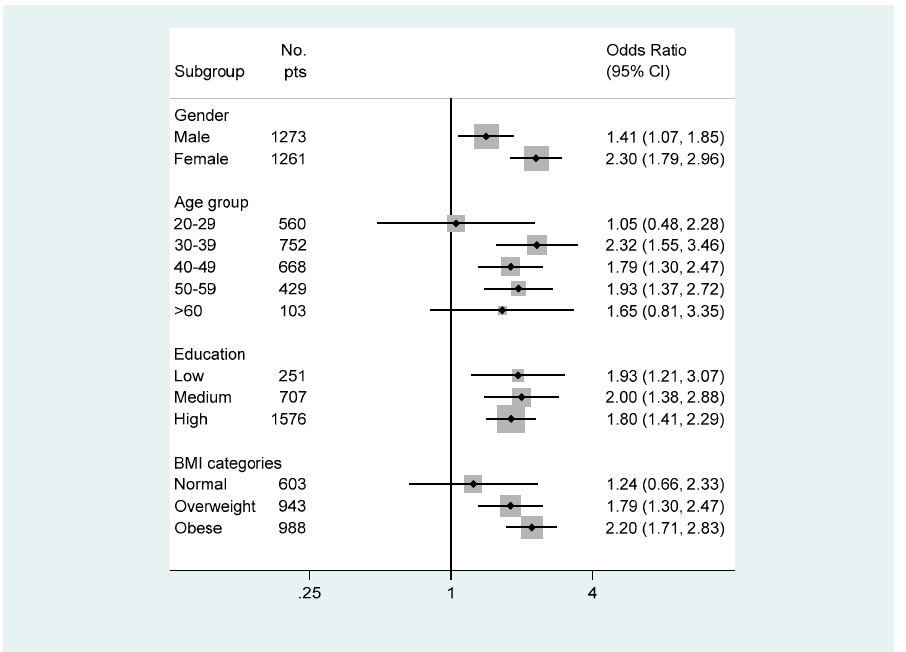
Figure 1. Subgroup analyses of the association between ABSI and diabetes.